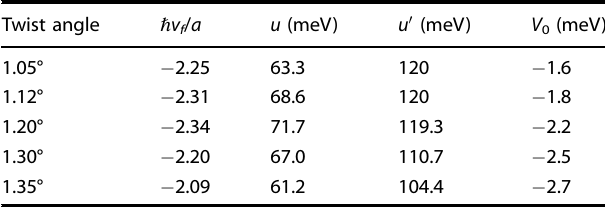
Fig. 4 Continuum model. Band structure of twisted bilayer graphene with θ = 1.05° calculated with TB (black lines) and continuum (red lines) model. a Free-standing TBG and b TBG/hBN. Table 1. Values for parameters of the continuum model of free- standing TBG obtained by the fi tting model to the TB calculations. Twist angle ℏ v f /